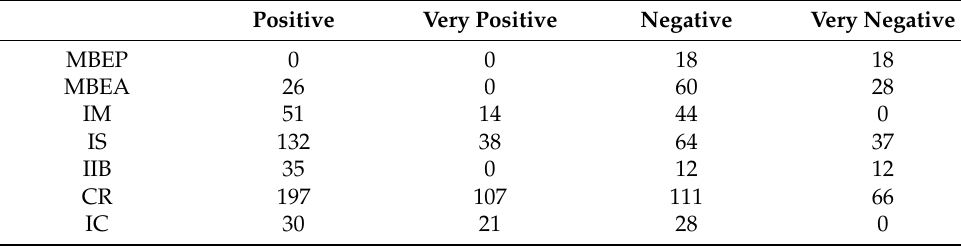
Table 4. Matrix coding with auto word